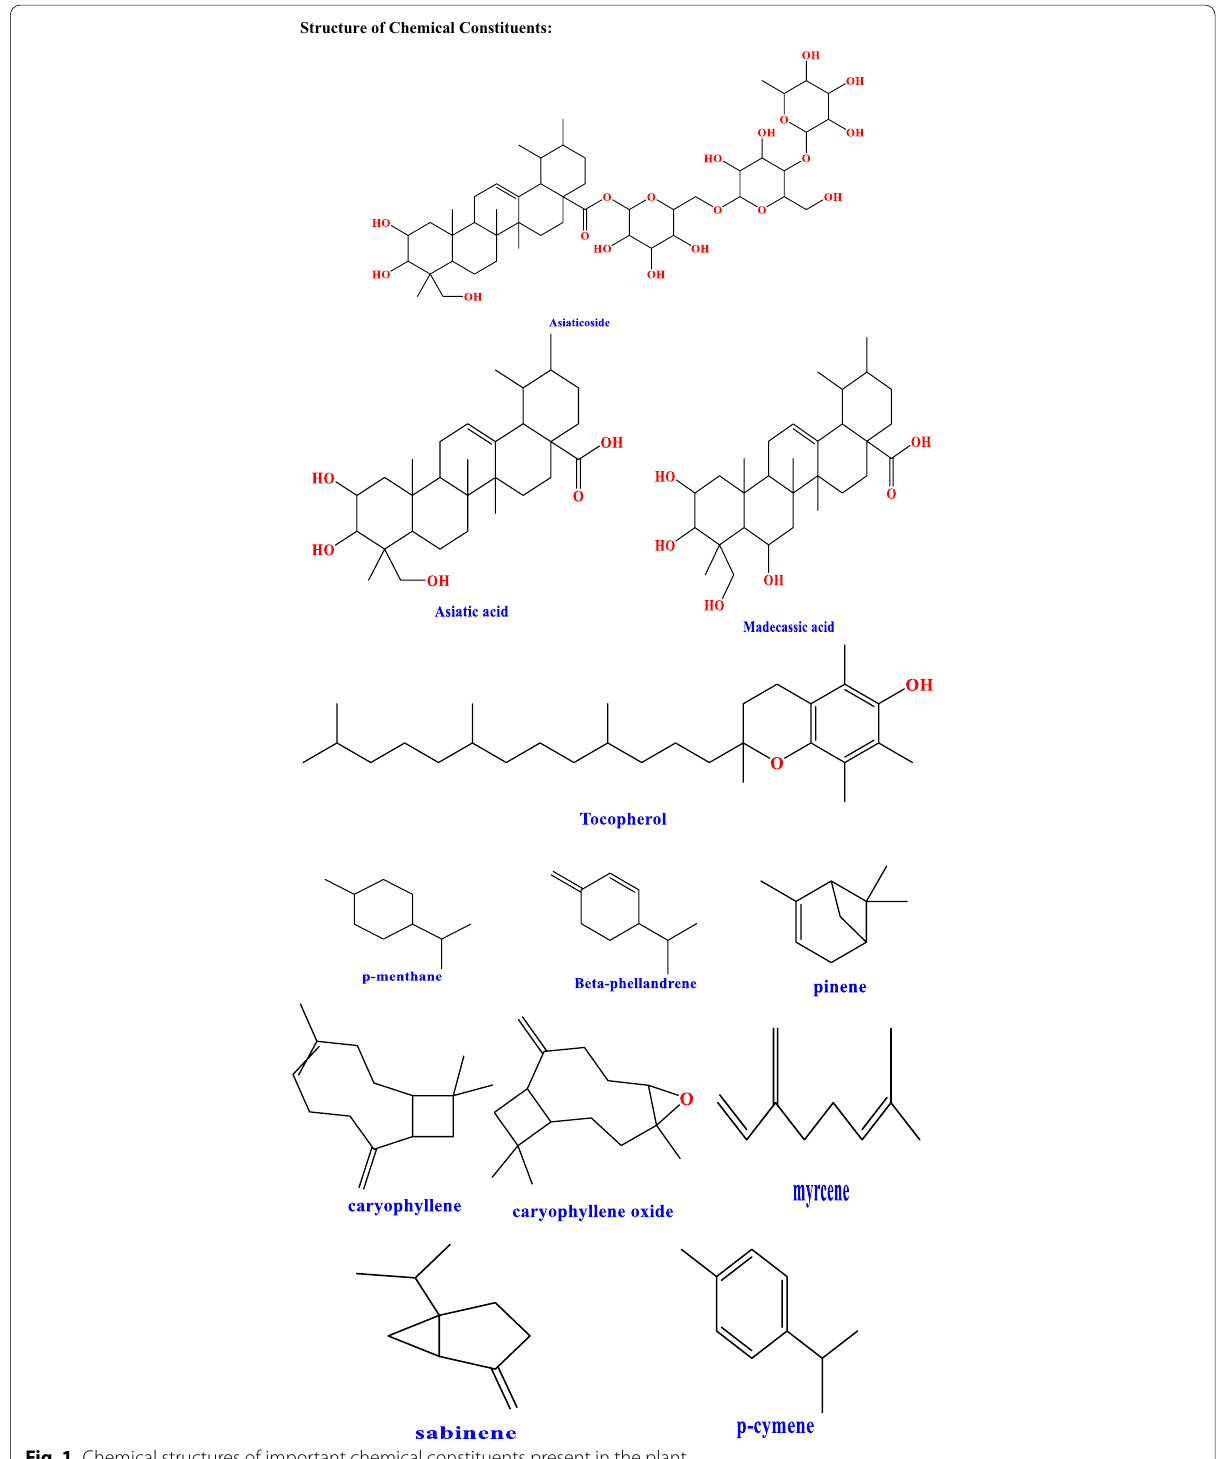
Fig. 1 Chemical structures of important chemical constituents present in the